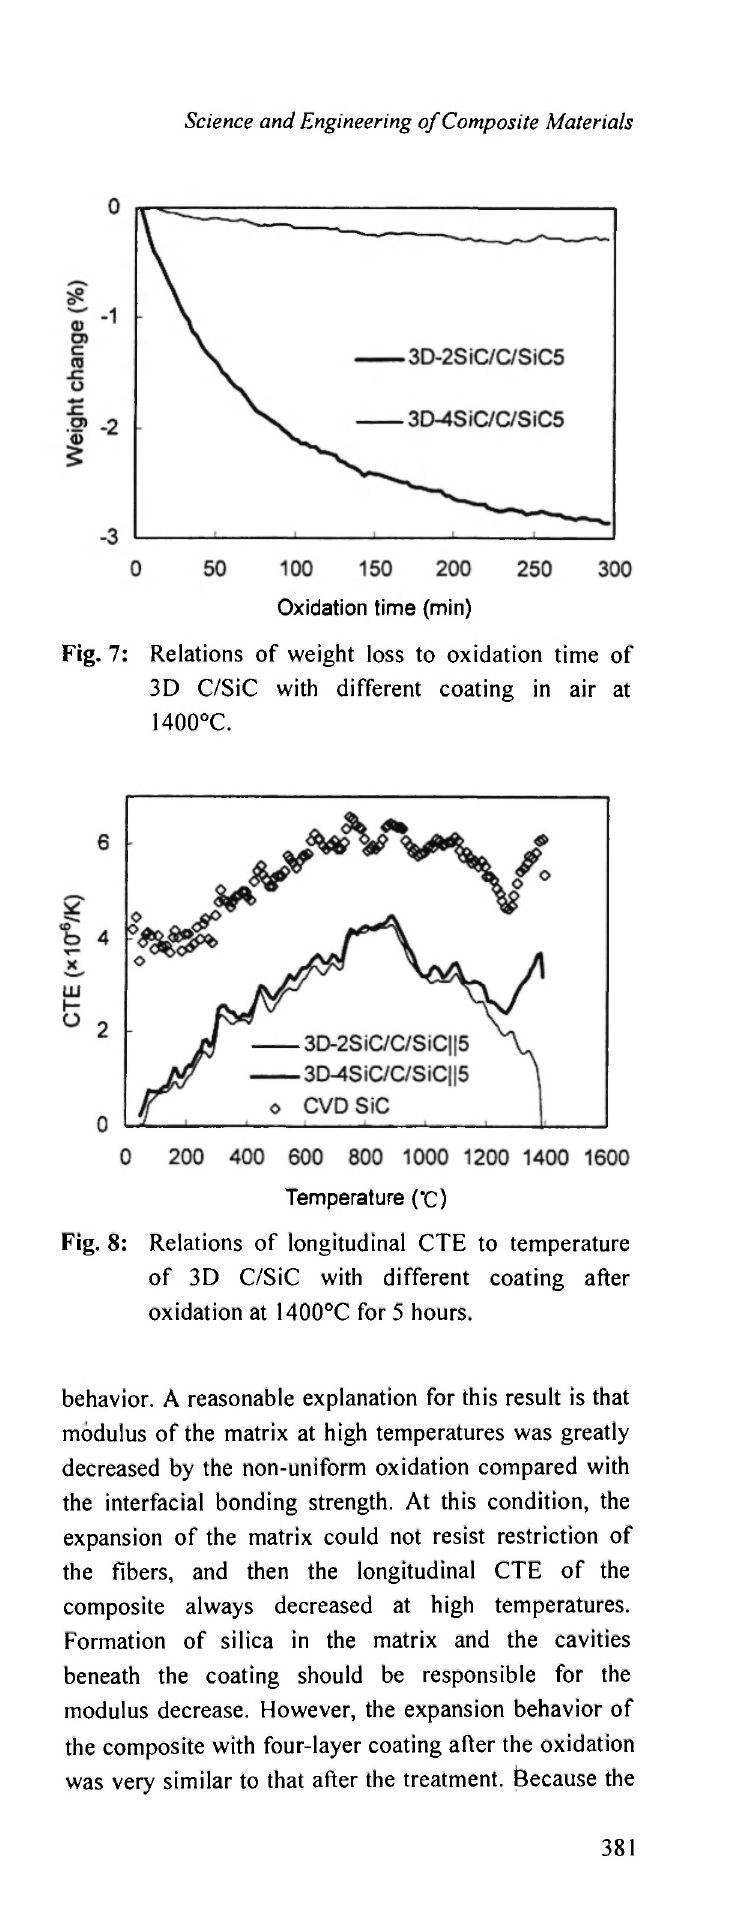
Oxidation time (min) Fig. 7: Relations of weight loss to oxidation time of 3D C/SiC with different coating in air at 1400°C.